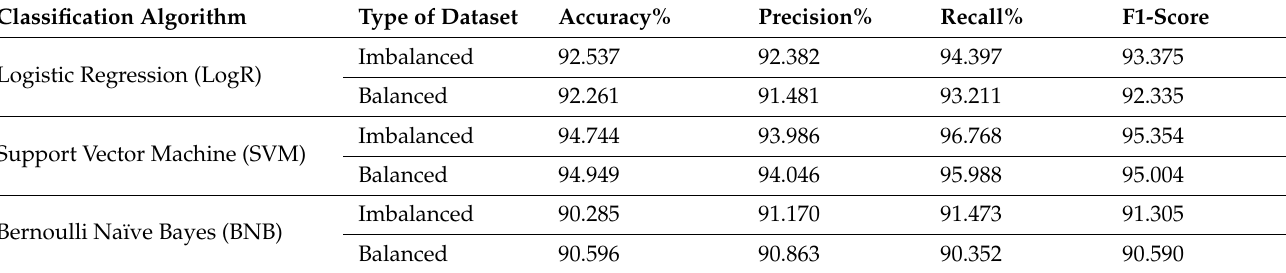
Table 8. Performance comparison of balanced dataset with imbalanced dataset (Dataset-1).